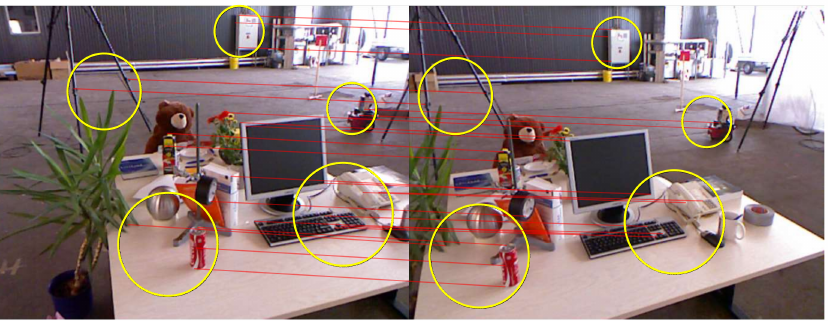
Figure 17. Schematic diagram of the feature matching using MLSS in the TUM